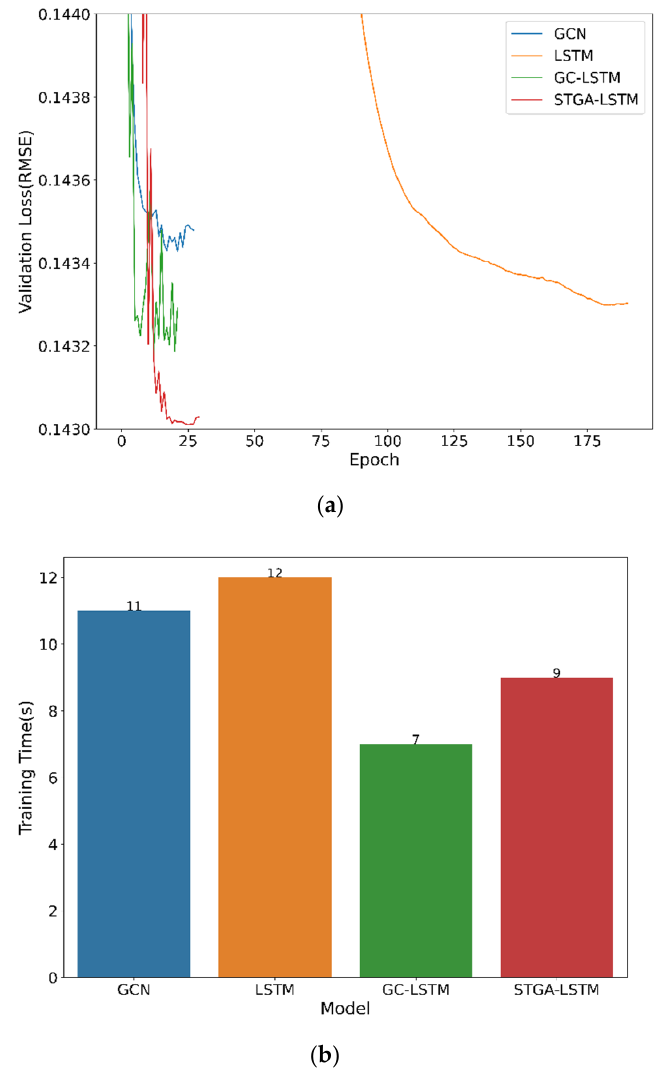
Figure 5. Model performance comparison of GCN and all the LSTM-based models. ( a ) Validation loss along with training epoch; ( b ) Total training time.